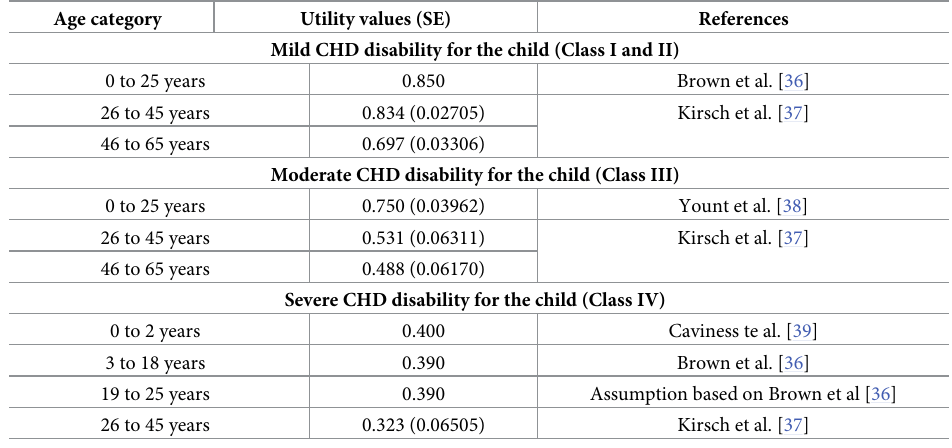
Table 6. Proxy utility values attached to different age group in patients with CHD diseases. Age category